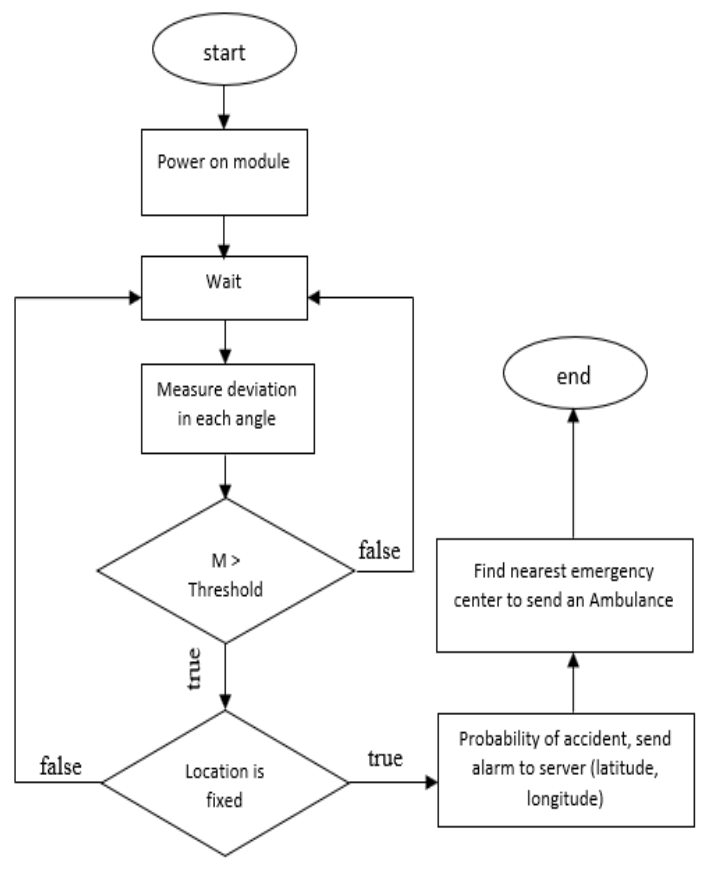
Figure 1. Diagram activity of the proposed assistive accident detection